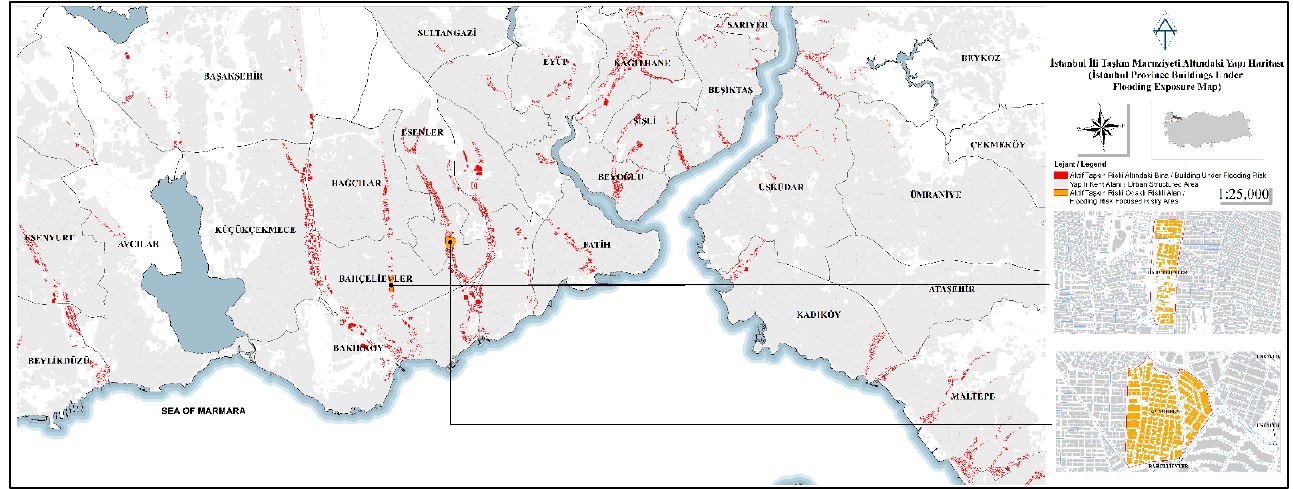
Figure 11. Istanbul Province Flooding Exposure Map (DSI & ISKI).